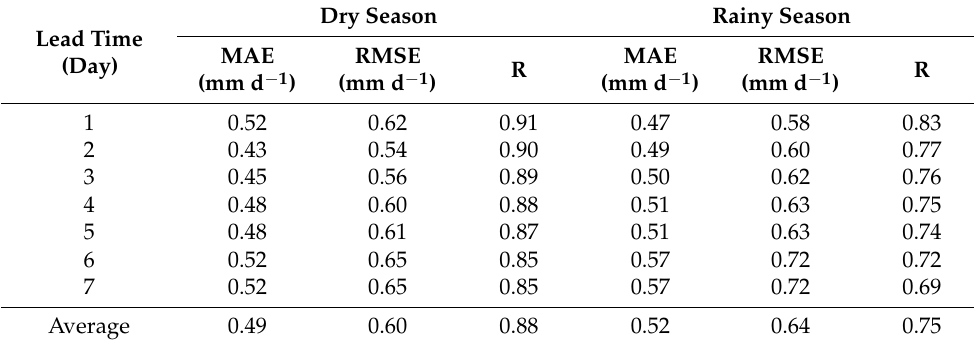
the three statistical indicators indicated that the performance of the ET 0 forecast slightly decreased with the increase in lead time regardless of the dry season or the rainy season. Table 4. Statistical indices of the ET 0 forecasts during 2016.